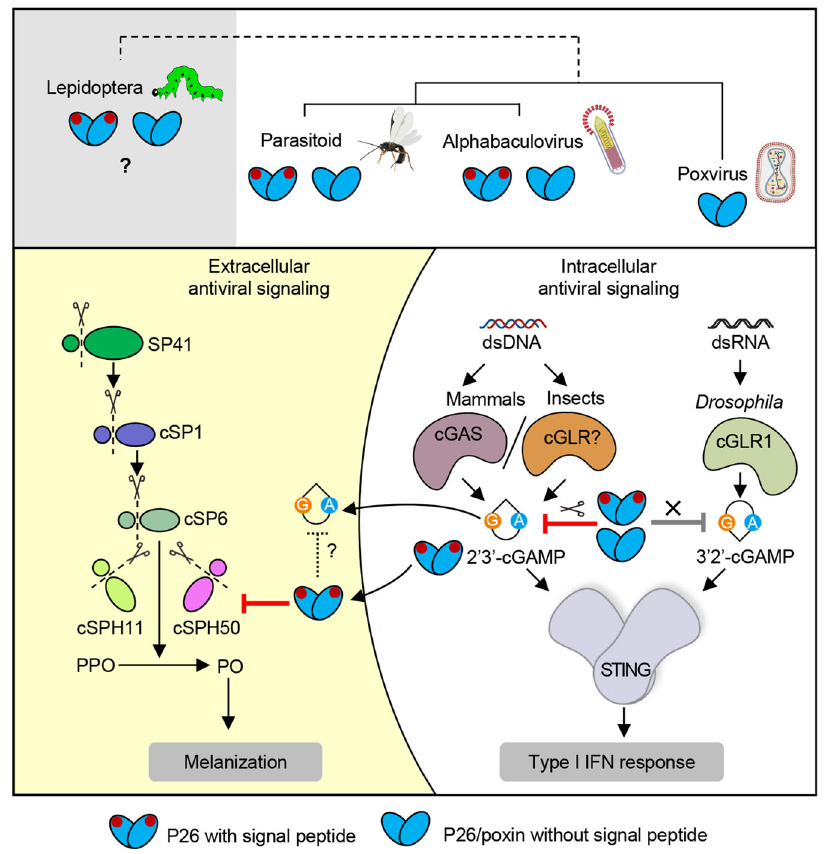
Fig. 7 | A model depicting the extracellular and intracellular roles of immunosuppression of poxin/P26. The signal peptide-containing P26s/poxins (labeled with red spot) from alphabaculoviruses or parasitoid wasps appear to contain both extracellular and intracellular immune suppression functions, whilst those without signal peptide either only harbor intracellular cGAMP degrading activity or lack both activities. Whether or not secreted P26 homologs from lepi- dopteran hosts function as extracellular melanization inhibitors is unclear and, thus,showningraybackground.Inthecytoplasmofmammalianandinsectcells,2 ′